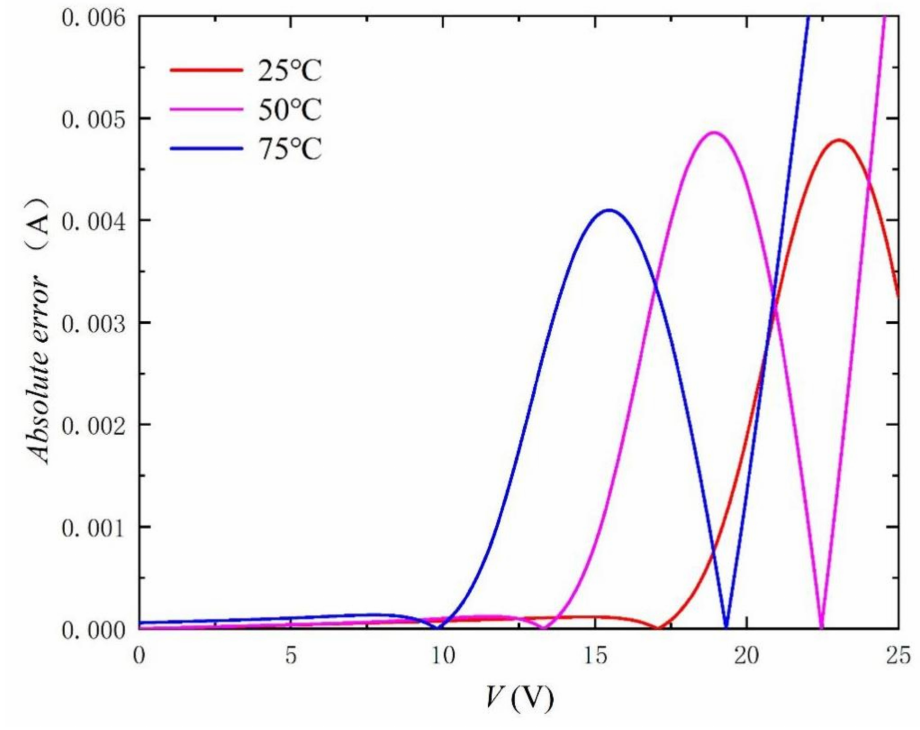
Figure 14. Absolute error curves between experimental data [33] and calculation results by using the extracted parameters listed in Table